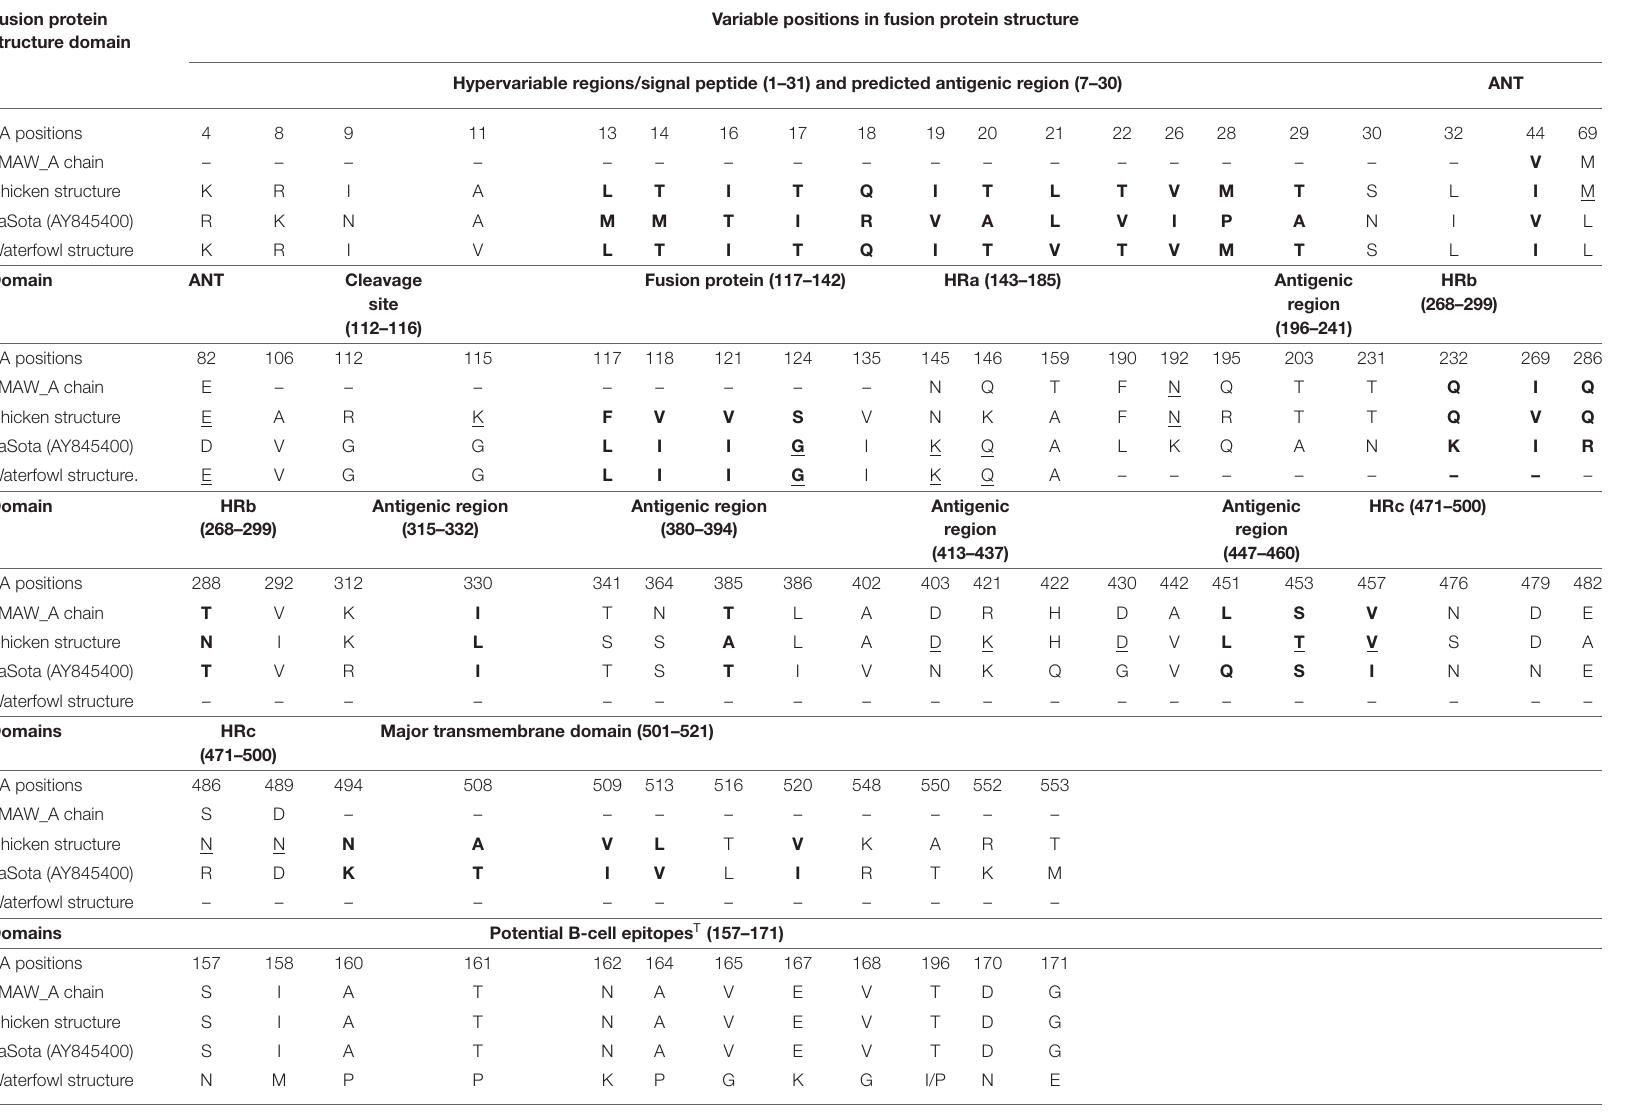
Variable positions found in the fusion protein mutated in poultry and waterfowl compared with LaSota vaccine virus strain—AY845400 used as a reference. Bold positions are surface-exposed residues in the variable situation predicted by discrimination of protein secondary structure class. Underlined positions contribute to the hydrophobic stability of the protein. ANT, antigenic region. T All these mutations were in only two waterfowl isolates but conserved in other waterfowl and in all poultry